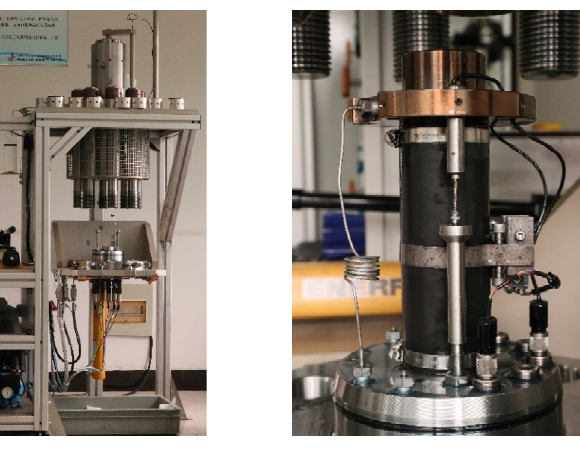
Figure 3. Triaxial compression test